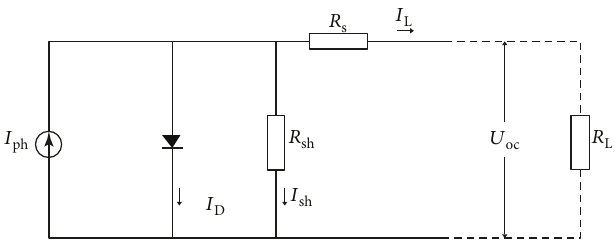
Figure 1: Equivalent circuit of the photovoltaic